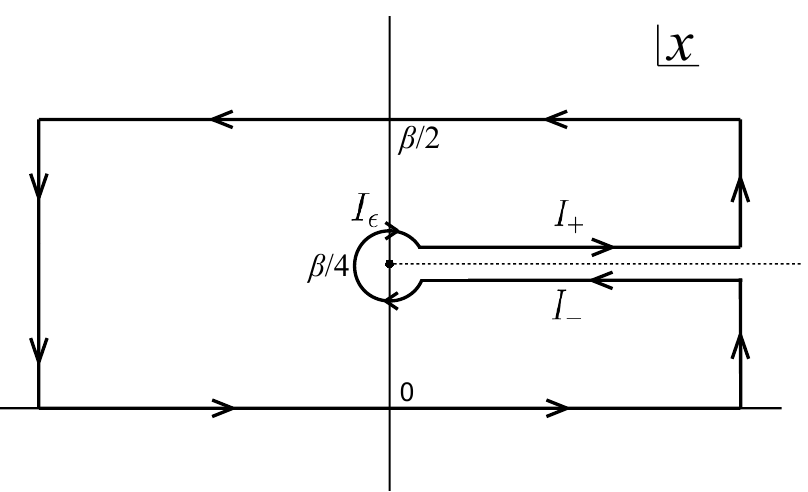
Figure 4 . Contour used to calculate the re(cid:13)ection coe(cid:14)cient of a Schwarzschild BH. The singularity is a branch point and the cut extends to in(cid:12)nity, parallel to the real